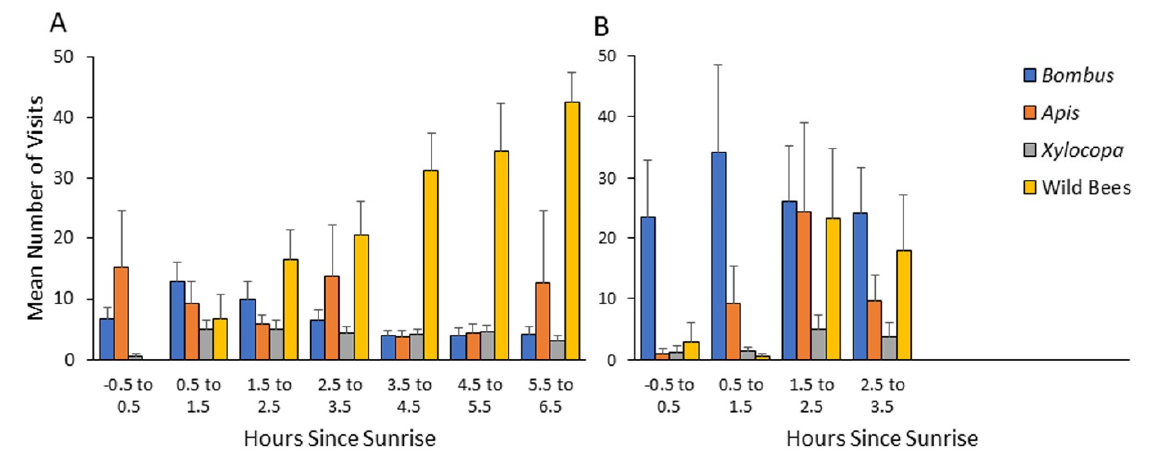
Figure 4. Mean number of visits per transect as a function of time after sunrise during 2013 ( A ) and 2014 ( B ) seasons at the Soreq site. Bombus — Bombus terrestris ; Apis—Apis mellifera ; Xylocopa —various species of the genus Xylocopa (mostly X. violacea , and to lesser extent X. pubescens and X. iris );.wild bees—all other bees not included in the three categories mentioned above. Bars indicate standard errors.